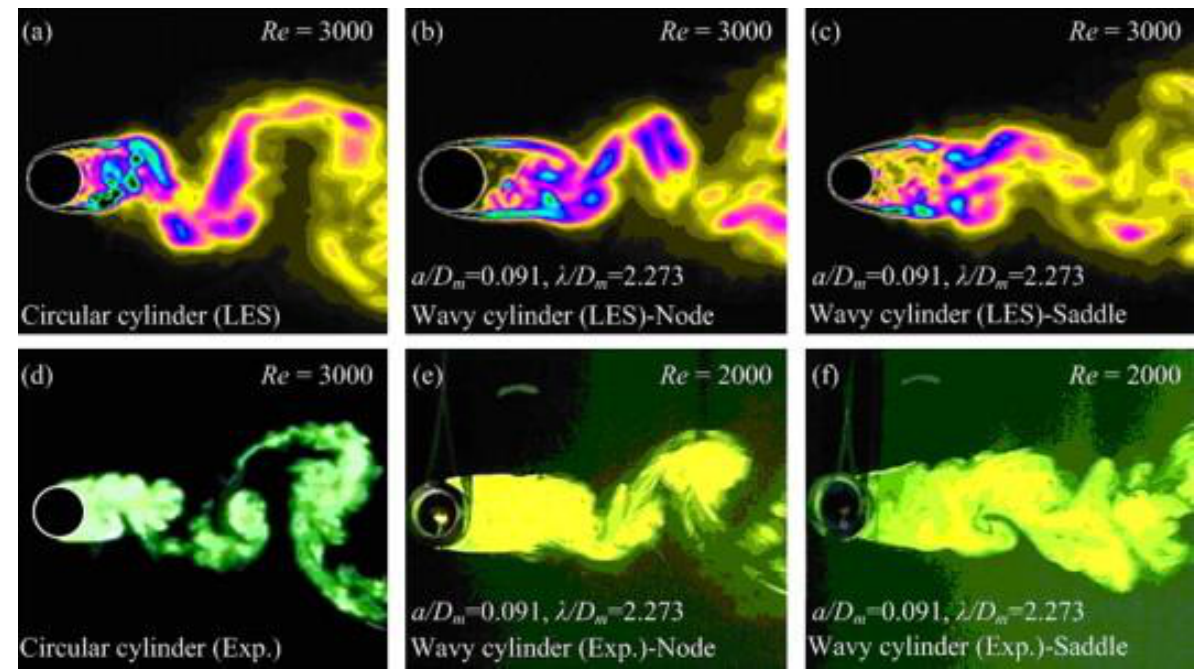
Figure 6. Experimental and numerical comparison of vortex structures of a circular cylinder and a wavy cylinder, ( a – c ) LES simulation; ( d – f ) LIF flow visualization; figure reprinted from Lam and Lin [48] Copyright (2008), with permission from Elsevier .